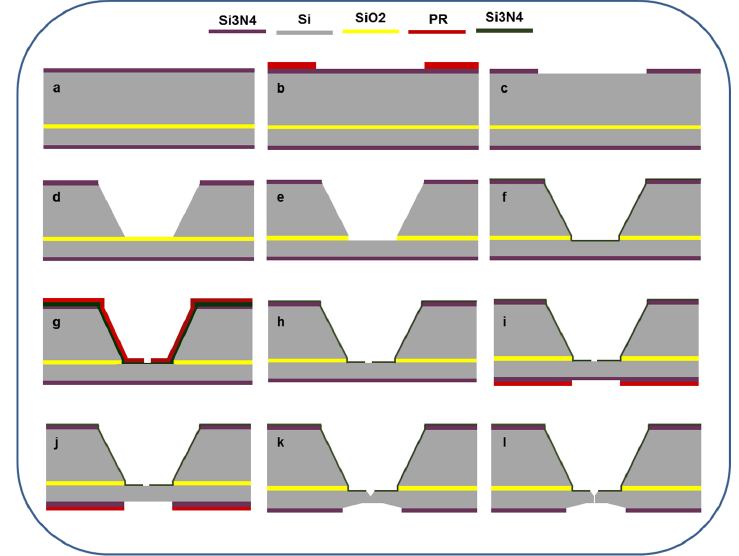
Figure 1. Cross ‐ sectional schematic flow for the production of a single solid ‐ state nanopore. ( a ) Deposition of 2 μ m Si 3 N 4 on both side of SOI wafer using PECVD; ( b ) patterning photoresist on backside of SOI wafer; ( c ) removal of exposed Si 3 N 4 using RIE; ( d ) anisotropically etched Si using 30% KOH; ( e ) removal of SiO 2 using 5 wt % HF; ( f ) sputtered 200 nm Si 3 N 4 on Si (n ‐ type); ( g ) patterning photoresist on n ‐ type; ( h ) removal of exposed Si 3 N 4 using RIE; ( i ) patterning photoresist on front side of the SOI wafer; ( j ) removal of exposed Si 3 N 4 using RIE; ( k ) formation of v ‐ shaped groove cavity on front side and square cavity on rear side of Si (n ‐ type) using a low concentration of KOH; and ( l ) formation of a nanopore in thin silicon membrane using an electrochemical setup.